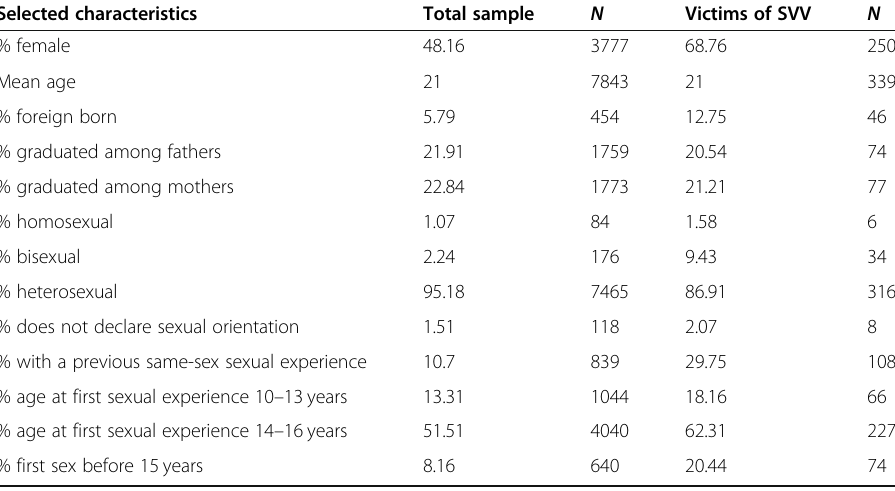
Table 2 Sample description according to selected characteristics, SELFY survey 2017 Selected